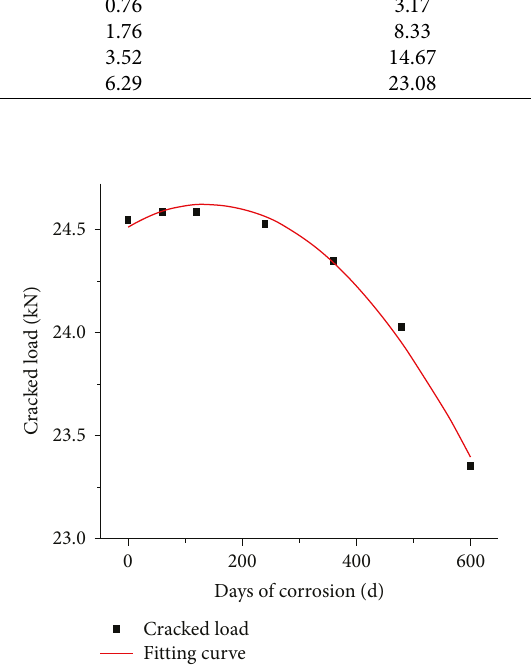
Figure 13: Fitting diagram of a variation of cracking load with sulfate corrosion